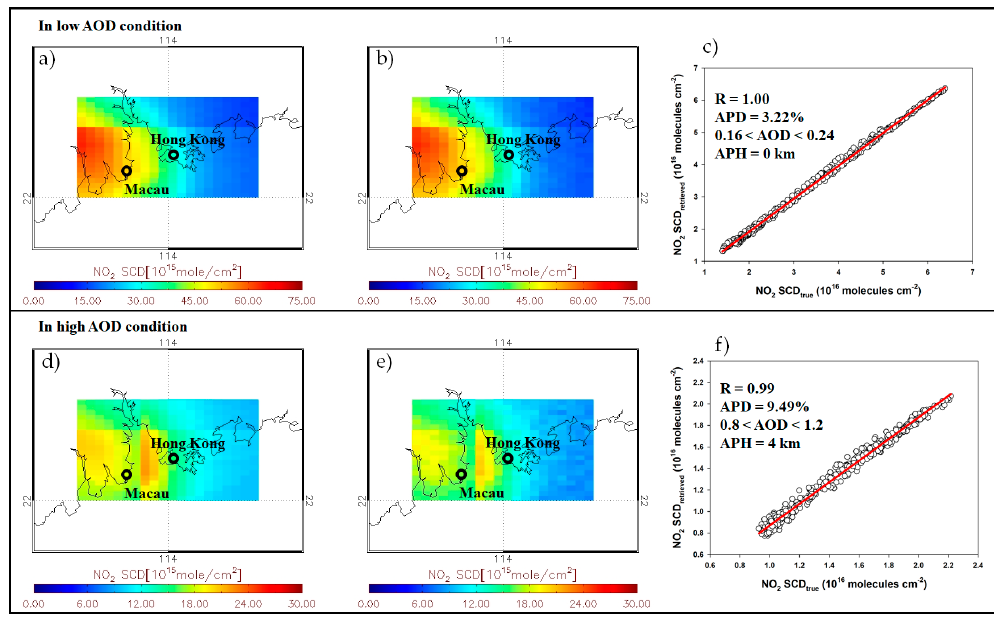
Figure 8. ( a ) True NO 2 SCDs, ( b ) retrieved NO 2 SCDs, and ( c ) a scatter plot between true NO 2 SCDs and retrieved NO 2 SCDs in the Hong Kong-Macau region in December 2011 under low-AOD conditions. Panels ( d – f ) are the same as ( a , b ) except under high AOD conditions. (Slant column density (SCD) and aerosol optical depth (AOD)).